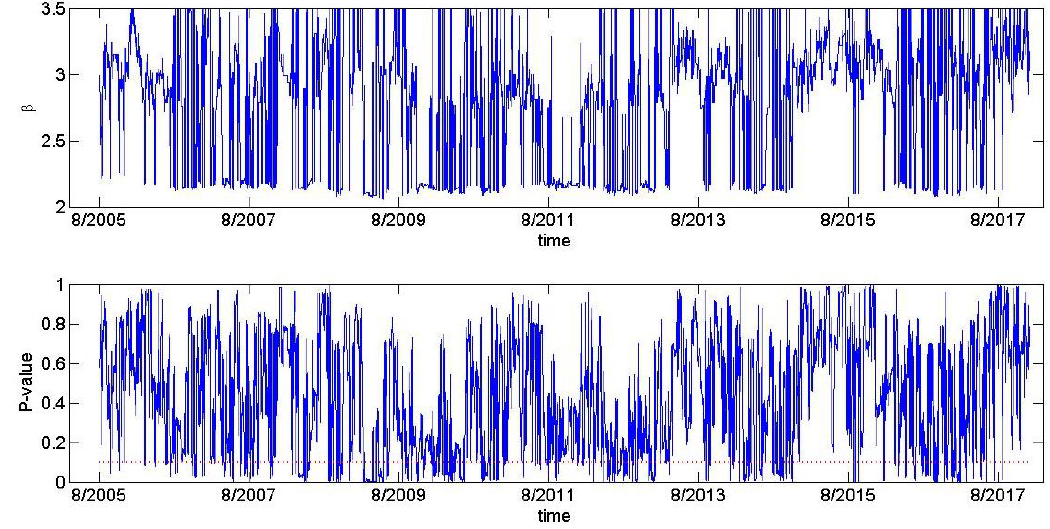
Figure 9. In the top panel, we estimated power-law exponent β of degree distribution at a different time. In the bottom panel, we estimated the corresponding p -value of the power-law exponent, and the red line denotes the value of 0.1. If the p -value is over 0.1, we accepted the power-law hypothesis, otherwise it was rejected.